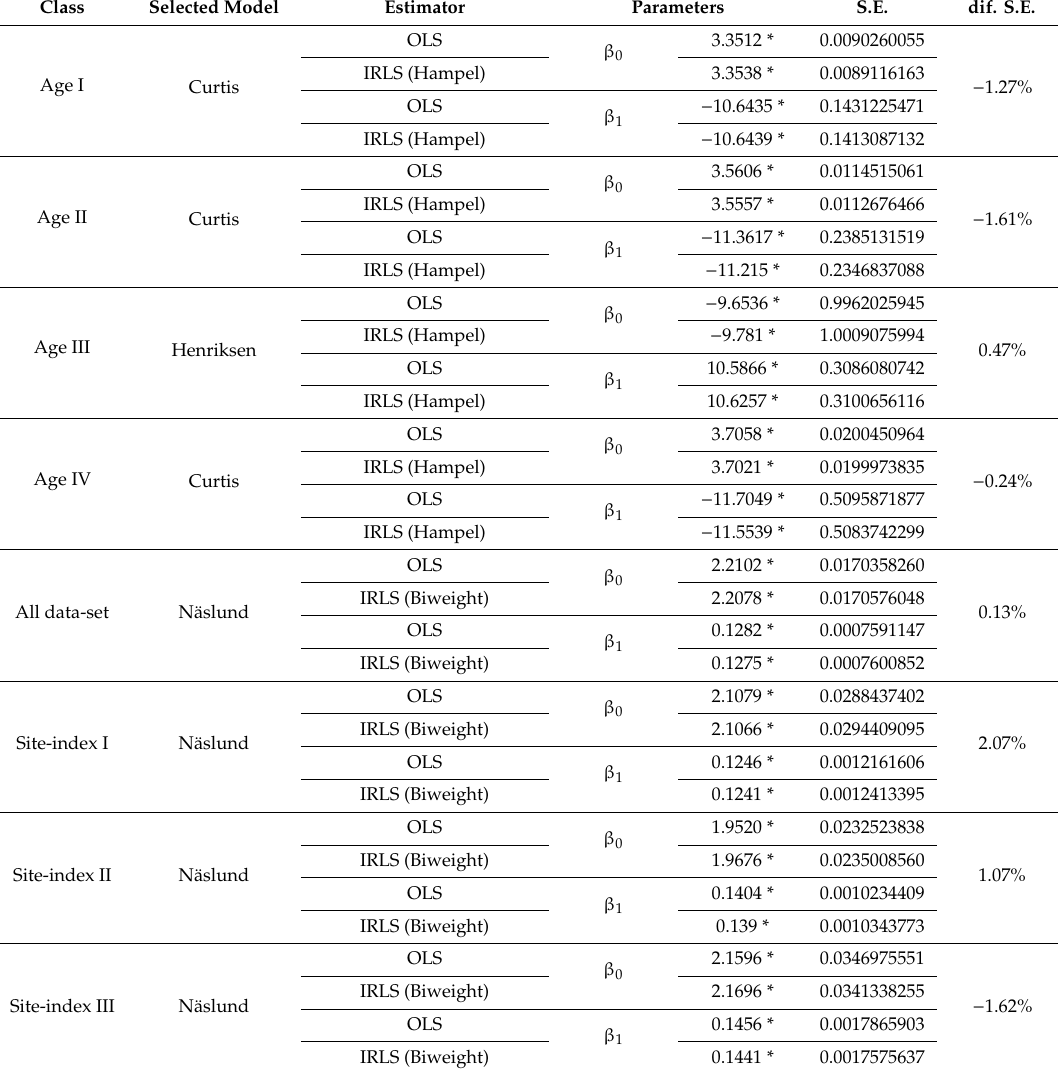
Table 7. Parameters standard errors of the most representative fit models for estimating the total height of Ochroma pyramidale (balsa-tree) trees by site-index and age classes in